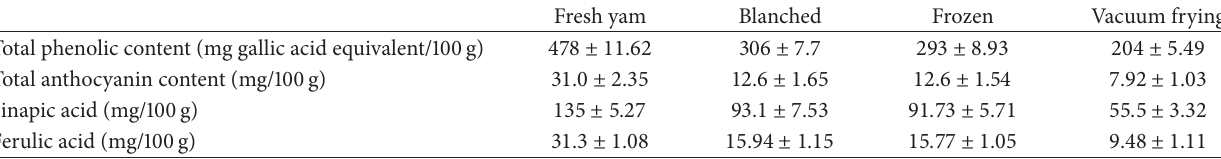
Table 4: Content of phenolic compounds during various processing methods of purple yam ( Dioscorea alata